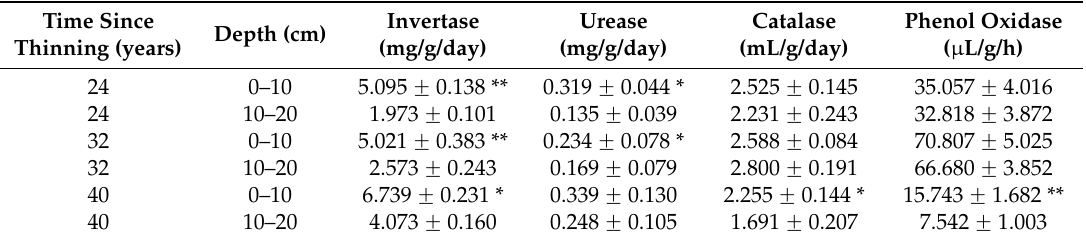
Table 4. Enzyme activity ( ˘ standard error) as influenced by time since thinning and mineral soil depth. Time Since Thinning